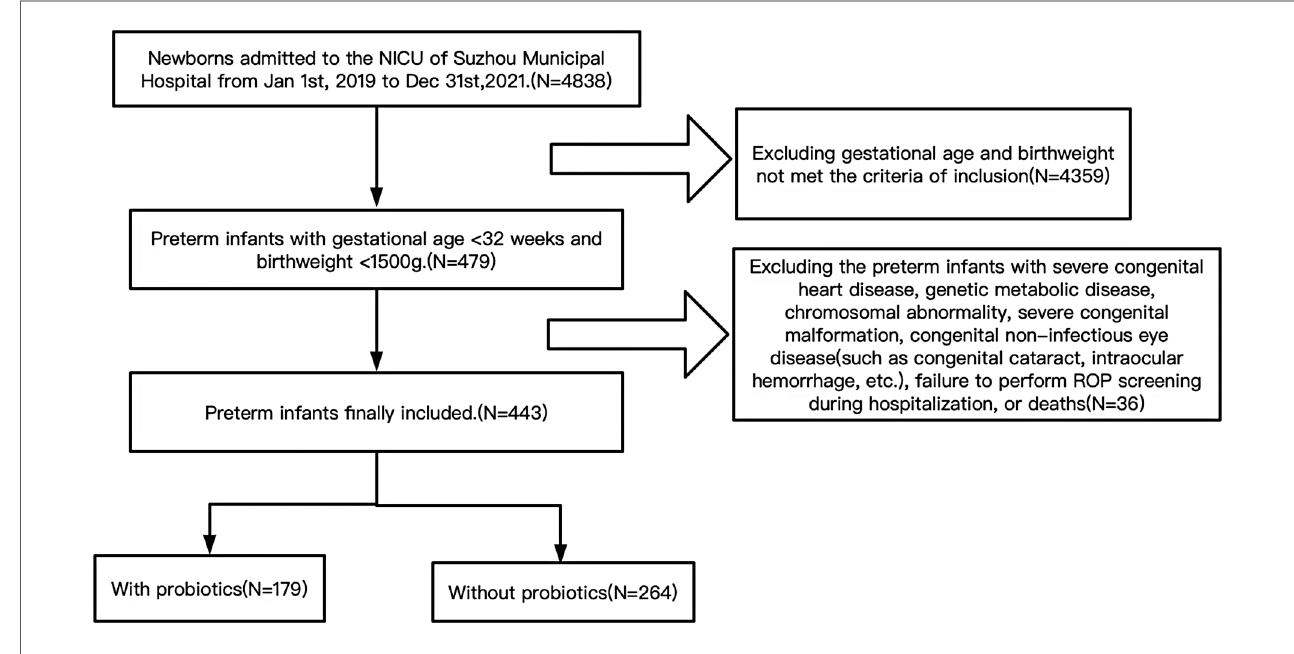
FIGURE 1 Flowchart of study population